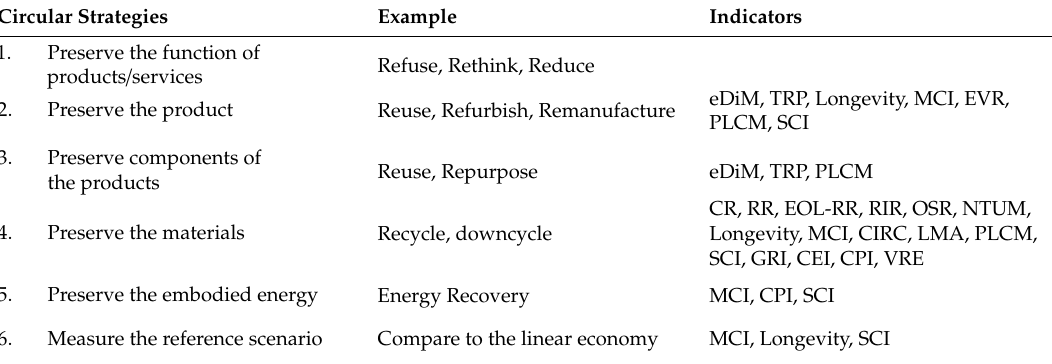
Table 3. Circular economy strategy and its indicators. Extracted from